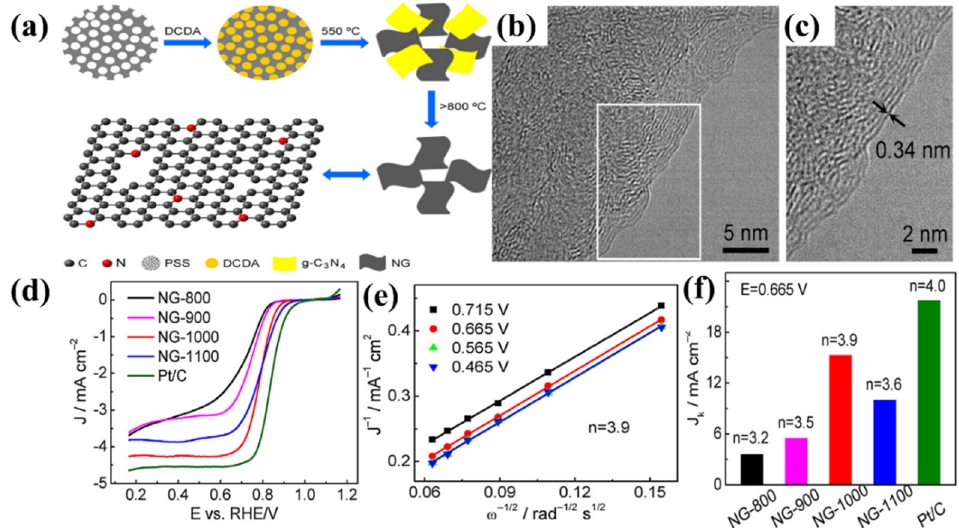
Figure 10. ( a ) Proposed synthetic mechanism for NG from PSS and DCDA, ( b ) high-resolution TEM images of NG–1000, and ( c ) the enlargement of the boxed area in ( b ), ( d ) LSV curves of different samples and Pt/C electrodes in O 2 -saturated 0.1 M KOH solution with a sweep rate of 5 mV s –1 at a rotation rate of 1600 rpm, ( e ) K–L plots of NG–1000 at different potentials, ( f ) kinetic-limiting current density of NG and Pt/C catalysts, as well as the corresponding transferred electron numbers at 0.665 V, adapted from [73].